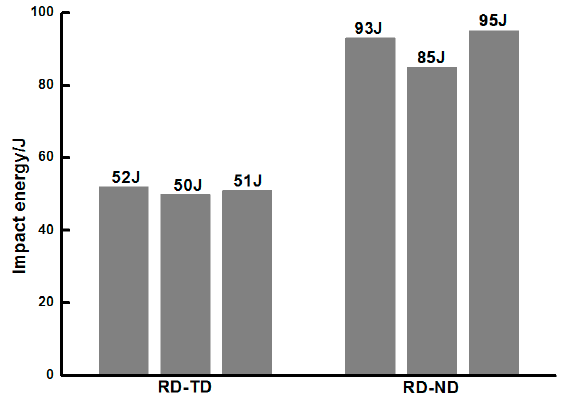
Figure 5. Impact energy for the RD-TD and RD-ND specimens.